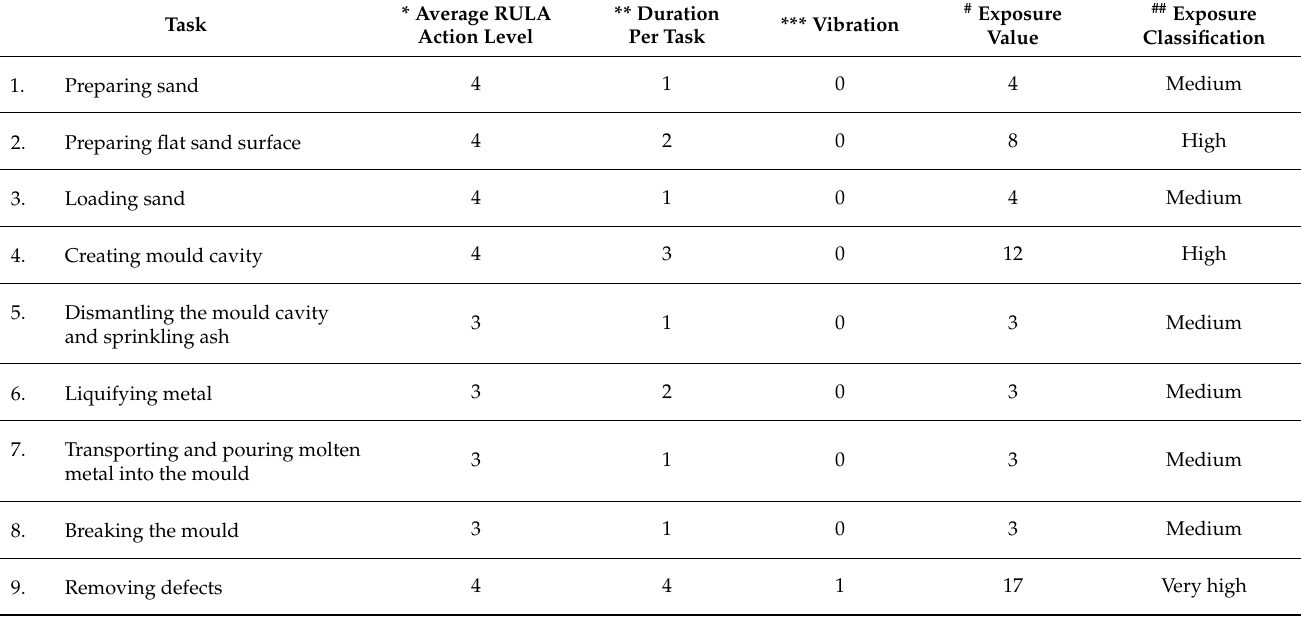
Table 4. Ergonomic